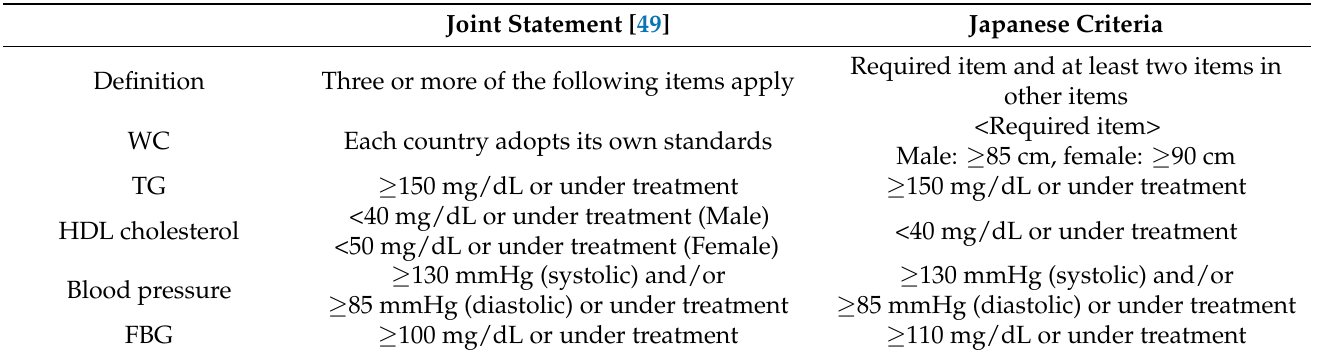
Table 1. Comparison of diagnostic criteria for metabolic